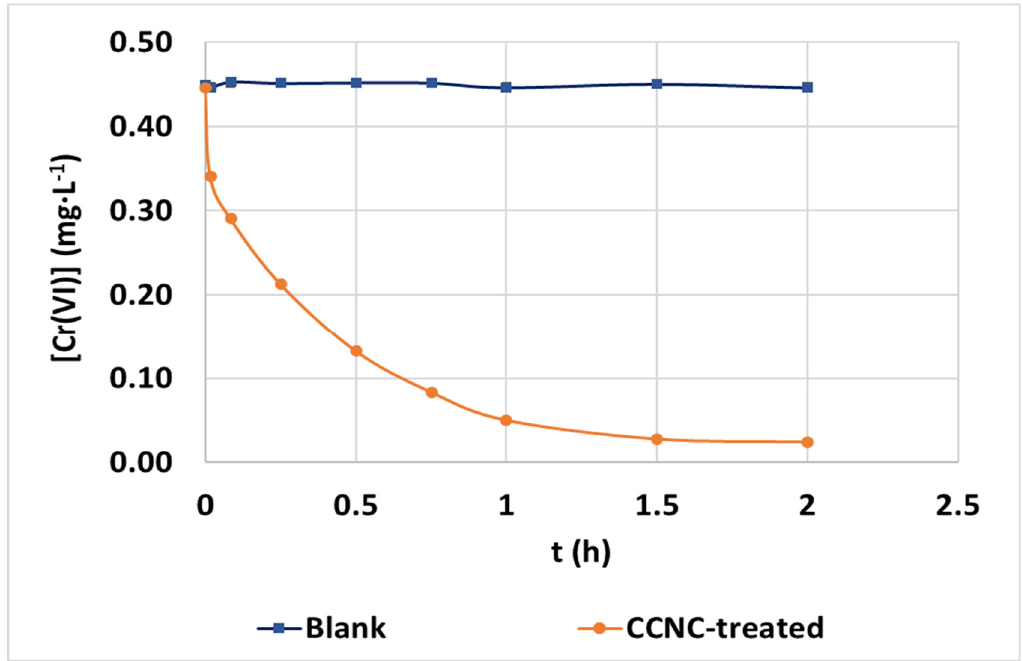
Figure 11. Evolution of hexavalent chromium concentration (mg·L −1 ) in blank and treated samples during adsorption batch treatment with CCNC of real wastewater under pH 3 and 100 mg·L −1 of adsorbent dosage.